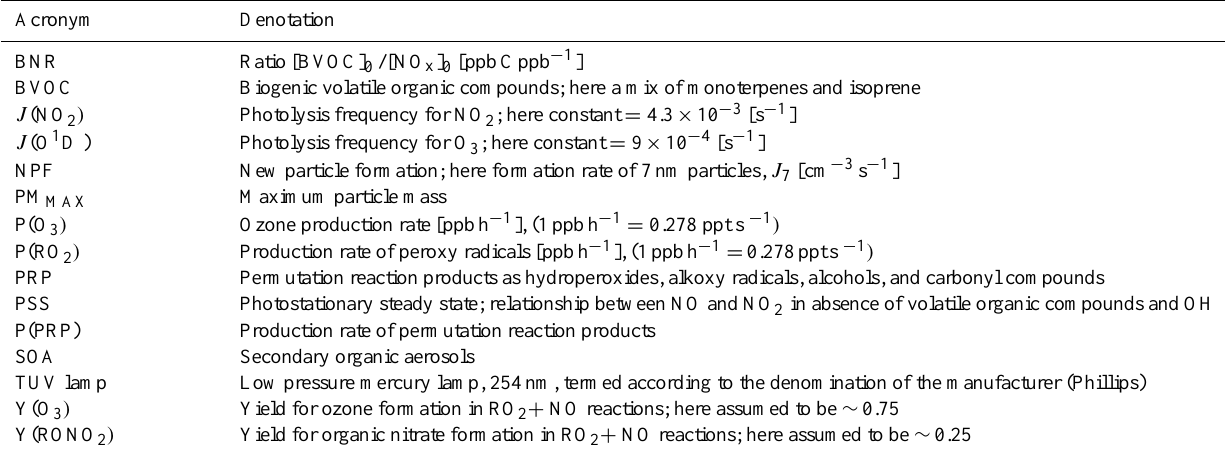
Table A1. List of acronyms used in the